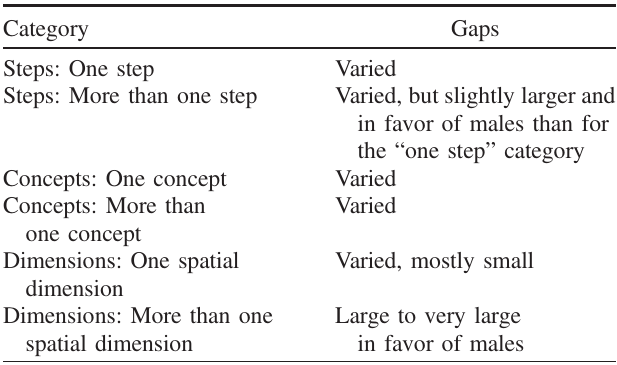
TABLE VII. Pattern of gender gaps within the difficulty